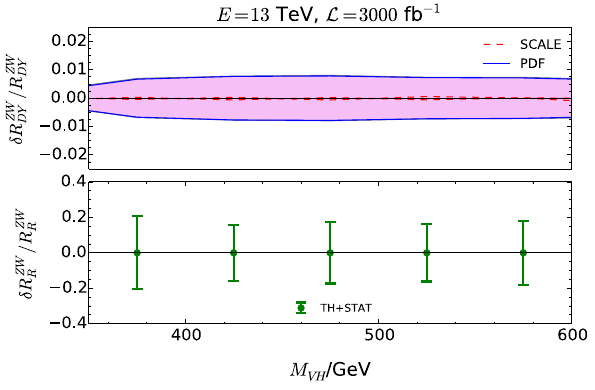
Fig. 9 The upper panel shows the “theoretical” uncertainty, i.e. the first term in Eq.(9). In the lower panel, the green error bars show the total relative uncertainty as dictated by Eq.(9). The SM gg → ZH (with K = 2) has been included in the “experimental” uncertainty. The invariant mass in the case of the WH channel was constructed through the combination of the reconstructed four-momenta of the W boson and the Higgs boson. For the W boson, a random choice was made between the two solutions for the z component of the neutrino momentum